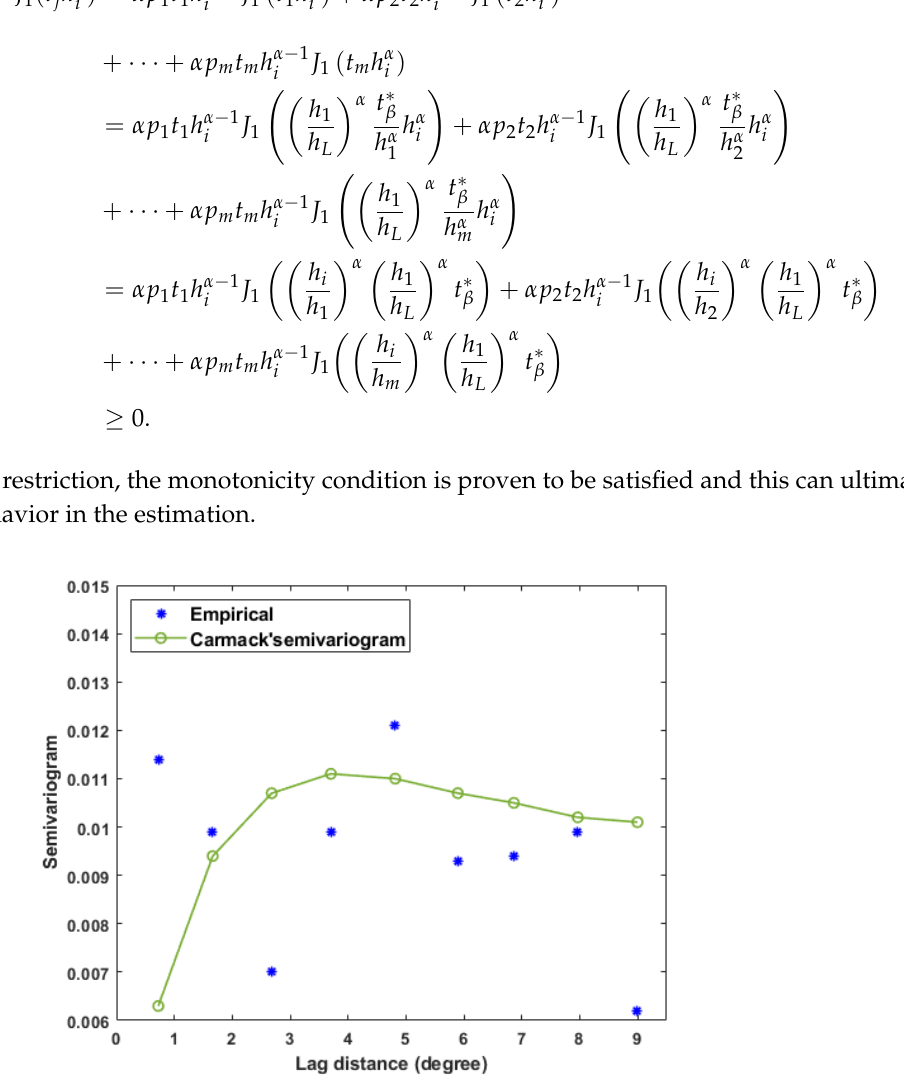
Figure 2. An illustration when the monotonicity constraint is not imposed in the